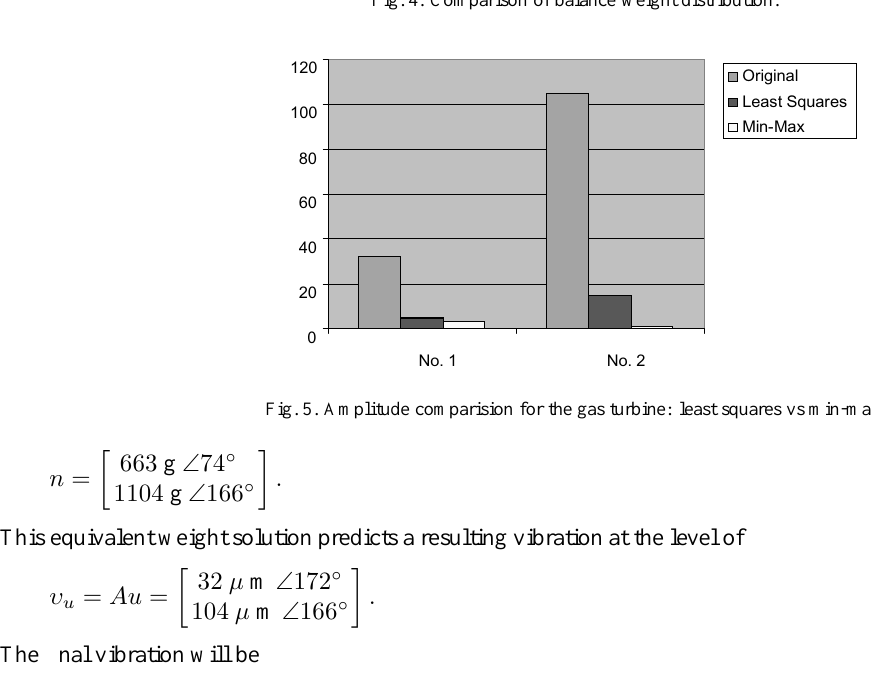
Fig. 4. Comparison of balance weight distribution.